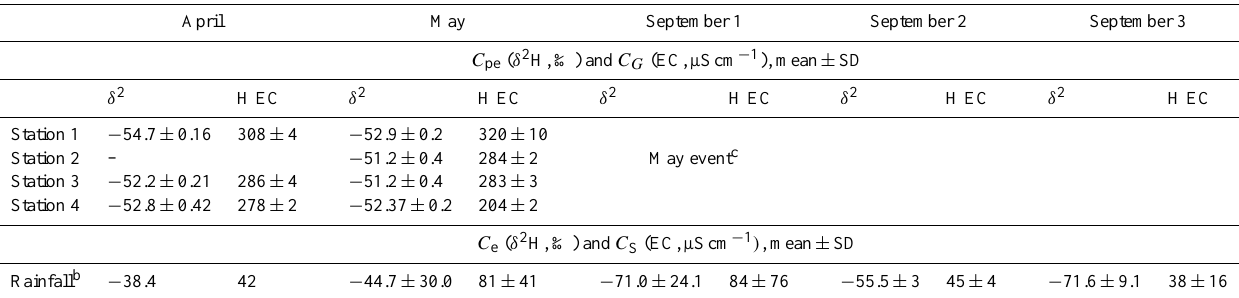
Table 5. Mean ± standard deviation of stream water and rainfall EC and δ 2 H signatures used as pre-event – ( C pe ), subsurface – ( C G ) a , event – ( C e ) and surface – ( C S ) b components for the hydrograph separations.